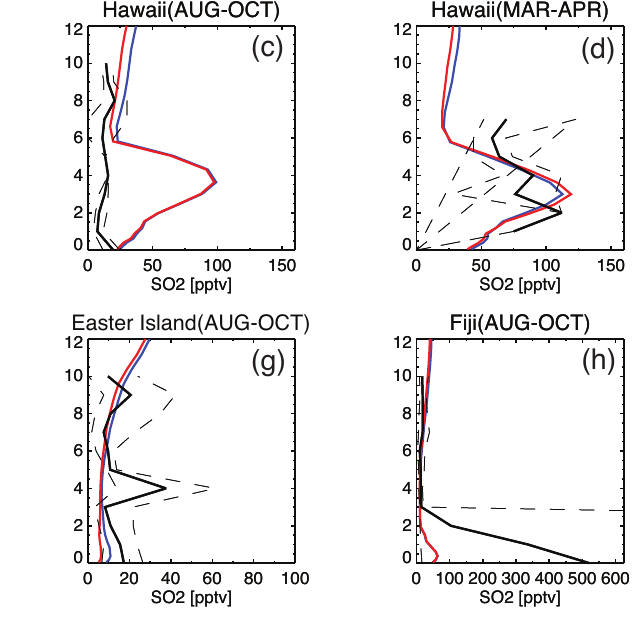
Figure 5. The same as Fig. 4 but for SO 2 vertical profiles.